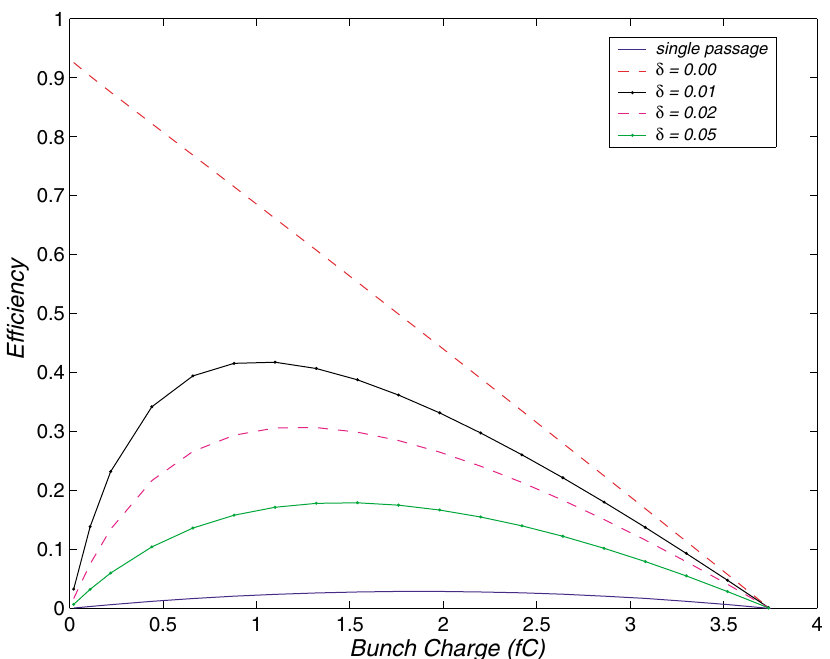
FIG. 8. (Color) Efficiency as a function of bunch charge for h G